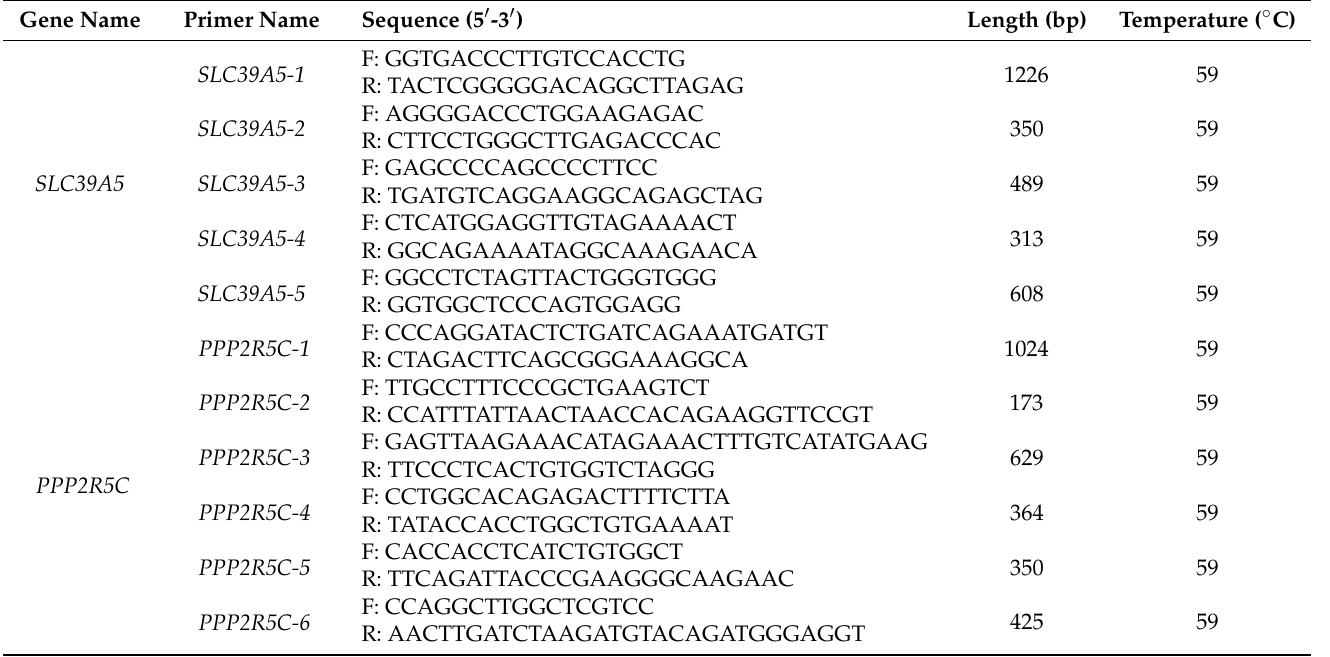
Table 2. Primer sequences for the promoter regions of PPP2R5C and SLC39A5 .